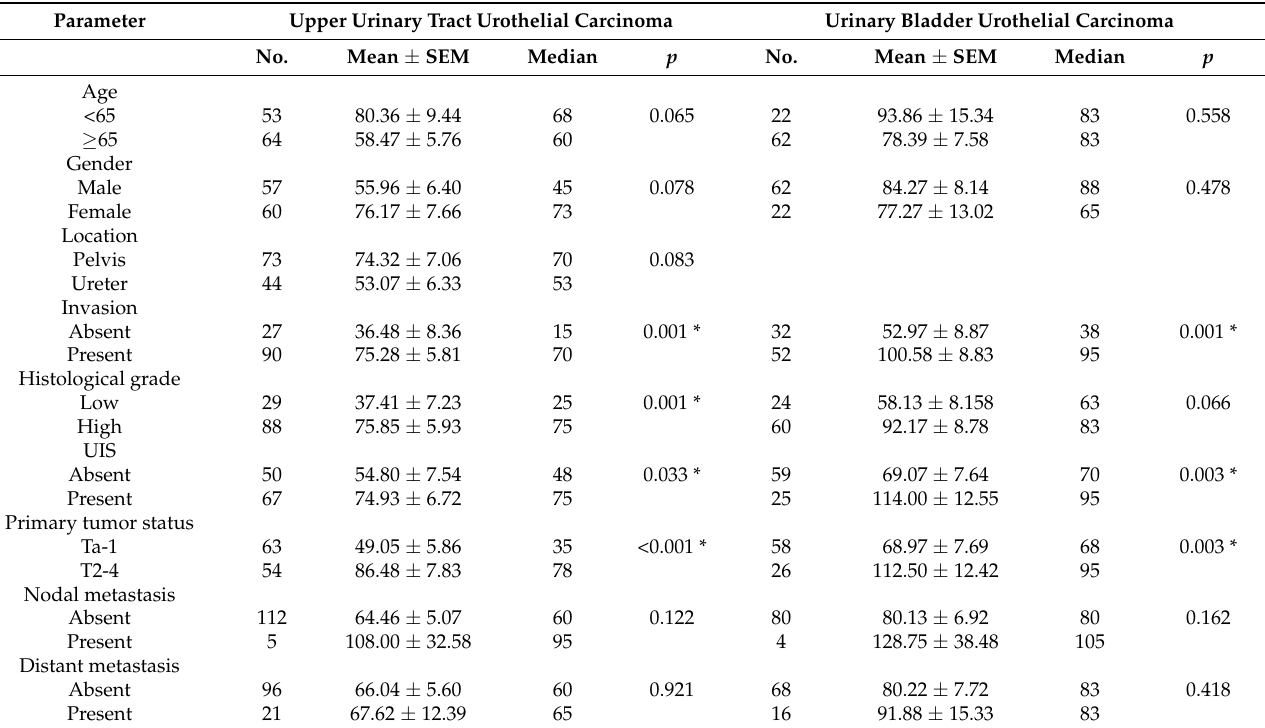
Table 1. Relationships between the immunoscore of SERPINE2 and clinicopathological parameters in 117 UTUC and 84 UBUC patients.